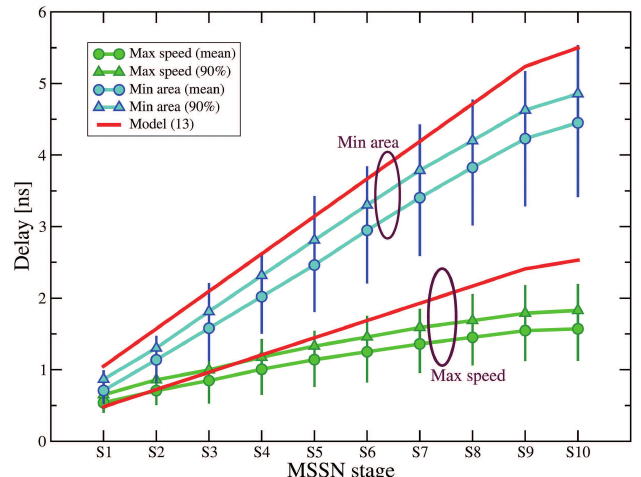
Figure 9. 1024 × 1024 I/Os radix-2 MSSN in-to-out delays (with bypass exploitation at different